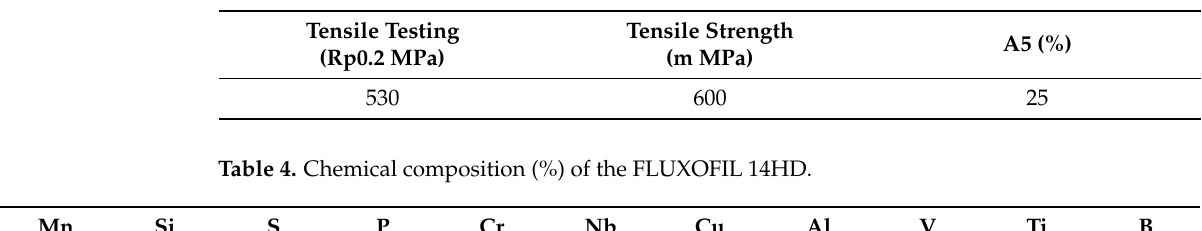
Table 3. Mechanical properties of FLUXOFIL 14HD.